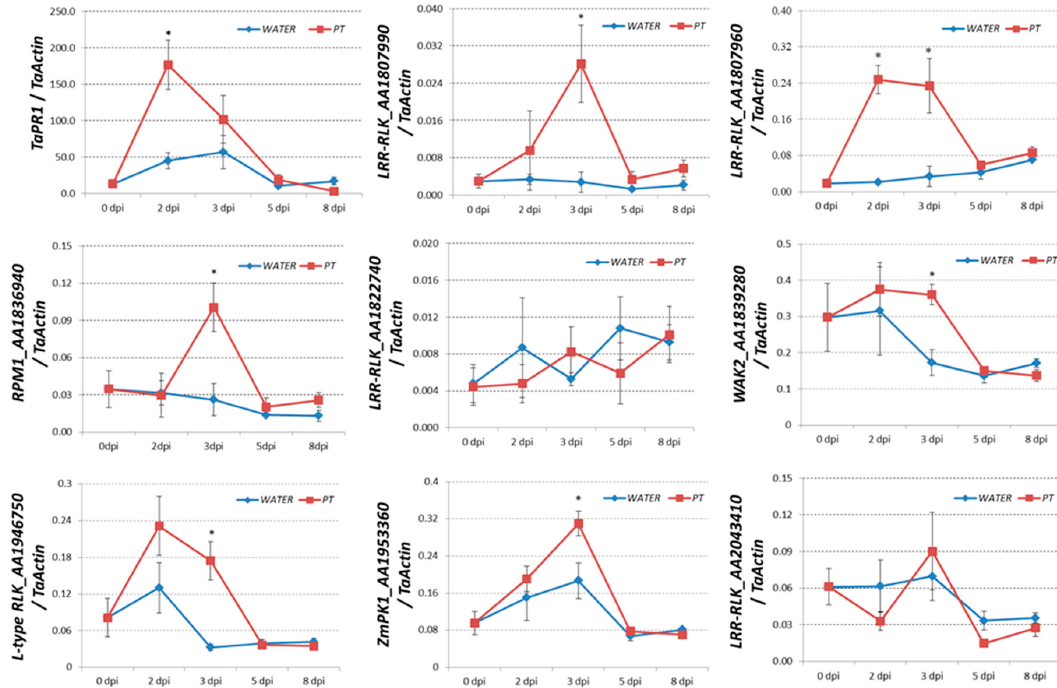
Figure 4. The expression profiles of selected genes encoding RLKs during the Lr47 -mediated resistance were determined by qRT-PCR assay. Fully-expanded third leaves of “ Lr47 -Yecora Rojo BC 6 F 5 ” line were spray-inoculated with leaf rust race THTT. Seedling plants of the same material sprayed with water served as a control. RNA samples were harvested at 0, 2, 3, 5, and 8 dpi. Five independent biological replicates were included. The transcript levels of all genes were expressed as linearized fold- TaActin levels using the 2 −Δ Ct method. Wheat pathogenesis-related TaPR1 gene was employed as a positive control. Mean and standard error of relative expressions were calculated, and two-sample t -test (* P < 0.05) was conducted using Microsoft Excel software.